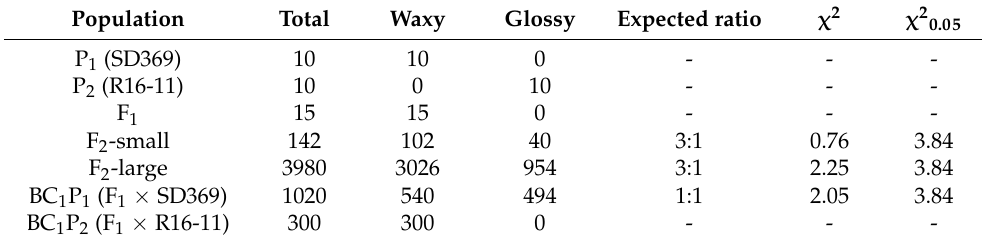
Table 1. Genetic analysis of the glossy trait in crosses between SD369 and R16-11. Population